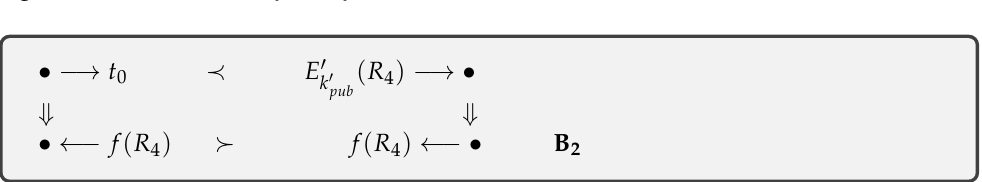
Figure 3. Skeleton B 1 : t 0 is { R 5 , R 6 } .